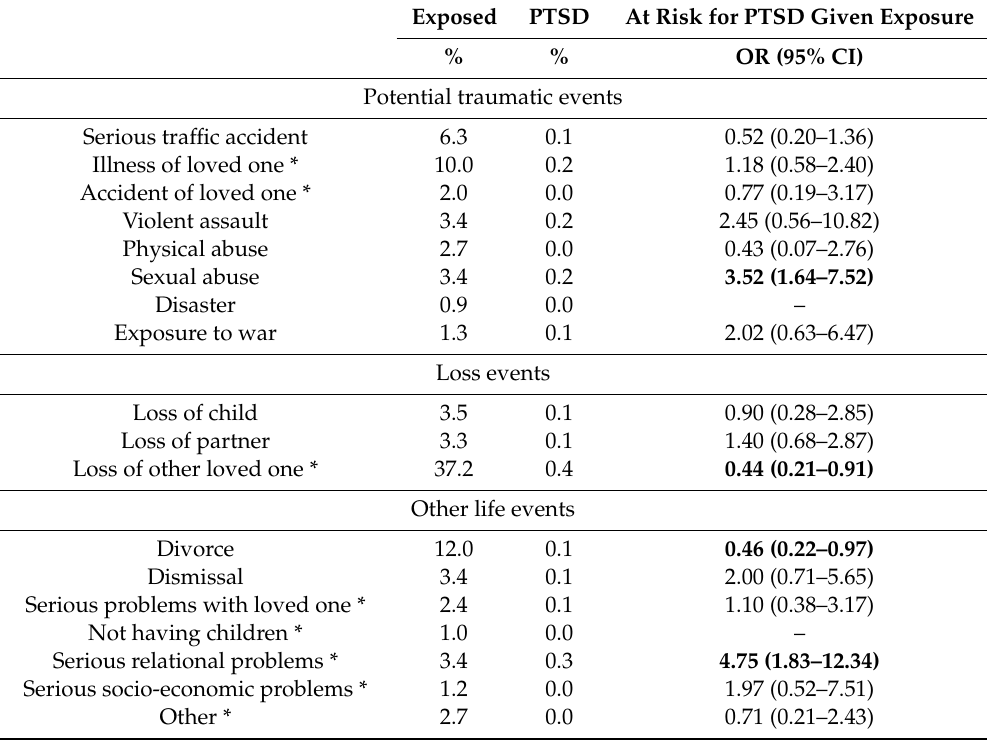
Table 2. The association between type of event and posttraumatic stress disorder (PTSD) (N = 4639). Exposed PTSD